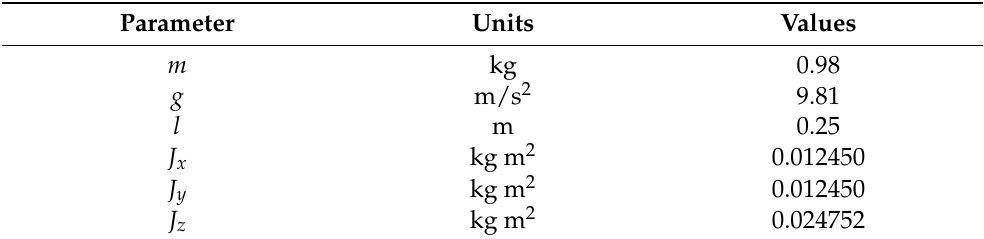
Table 1. Parameters of the 6DOF non-linear quadrotor